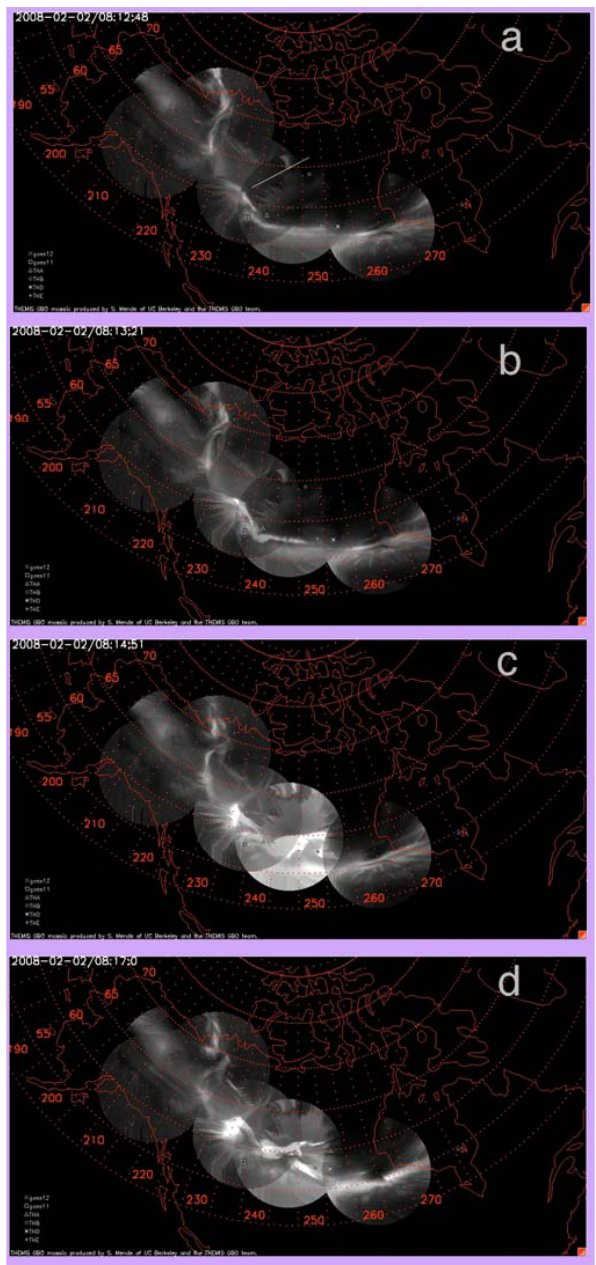
Fig. 15. (a) Onset at 08:12:48; (b) , (c) , and (d) the auroral image Figure 15 (a) onset at 08:12:48 (b), (c), and (d) the auroral image collages taken at the collages taken at the time when the magnetic signature is seen at time when the magnetic signature is seen at the location of the satellite THEMIS A the location of the satellite THEMIS A (08:13:21) THEMIS B and (8:13:21) THEMIS B and (8:14:50) and THEMIS D and E (8:17:00). (08:14:50) and THEMIS D and E (08:17:00).